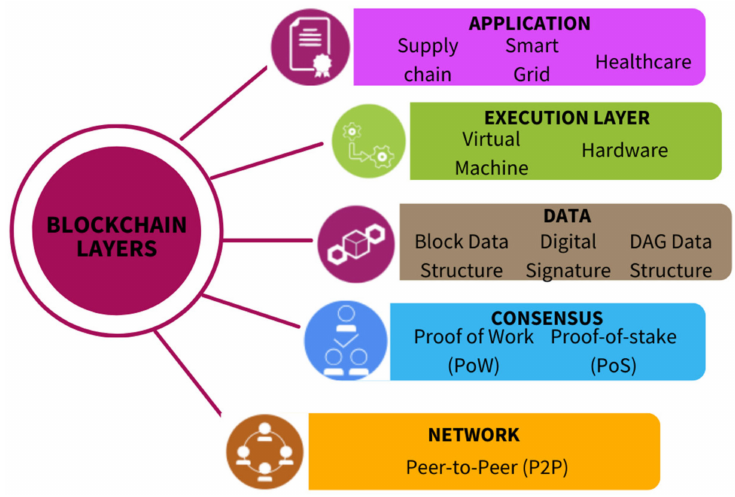
Figure 2. Five Different Layers of